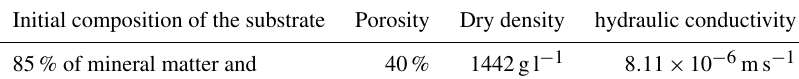
Table 1. Physical properties of the BGW substrate.